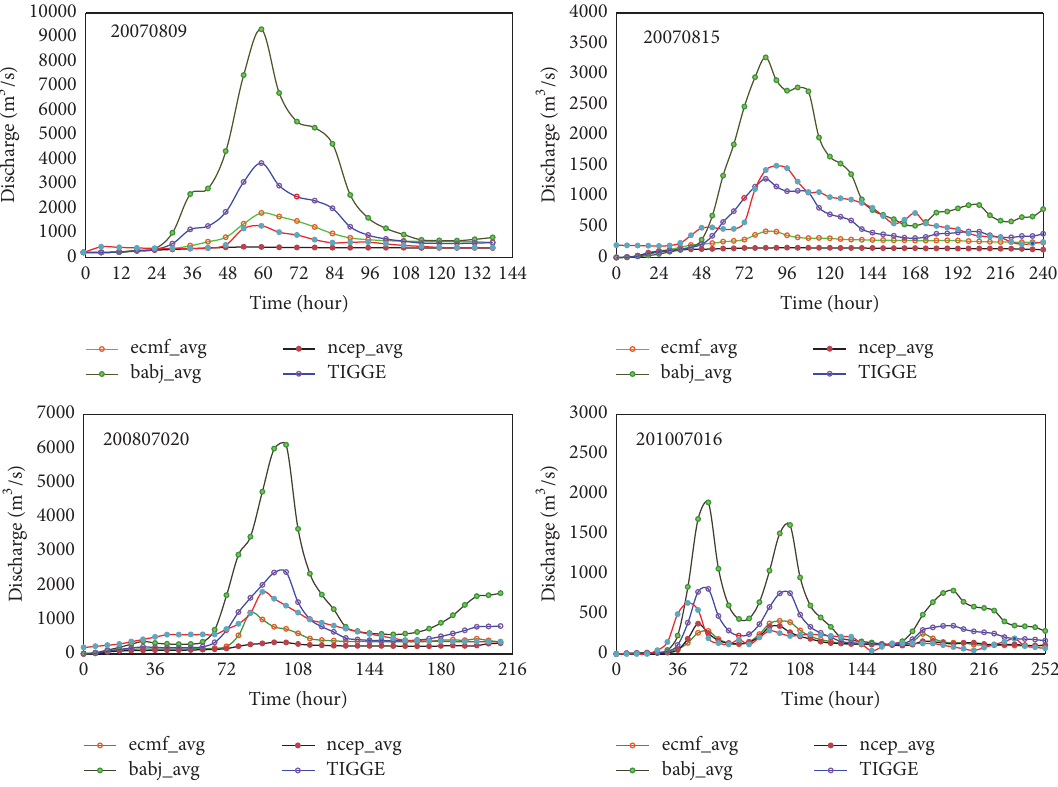
Figure 4: Comparison of the superensemble forecasted discharges from equal weight superensemble with observations (red lines with dots).